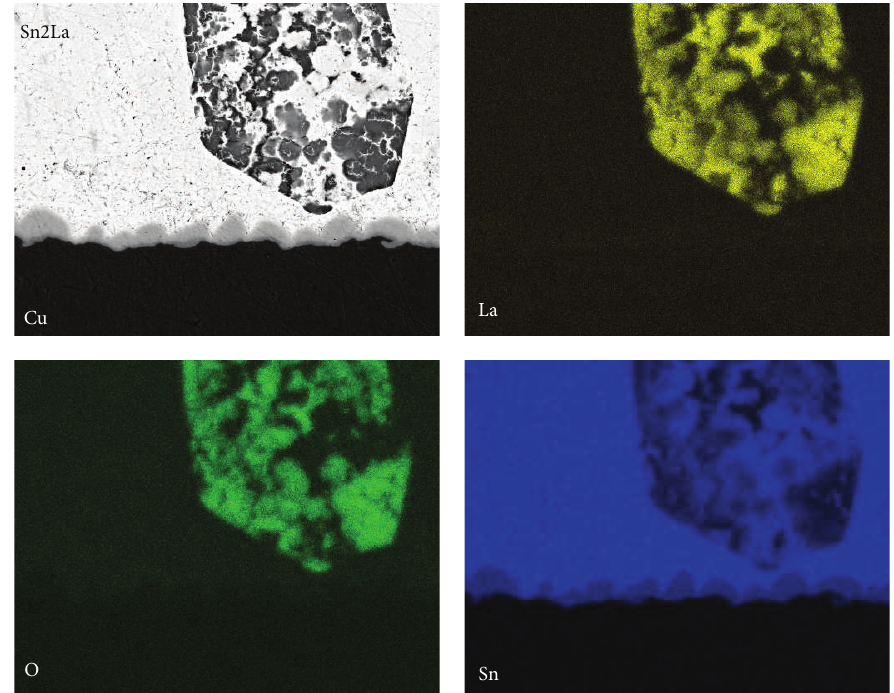
Figure 22: Planar analysis of Cu/Sn2La joint boundary with a sharp-edged lanthanum